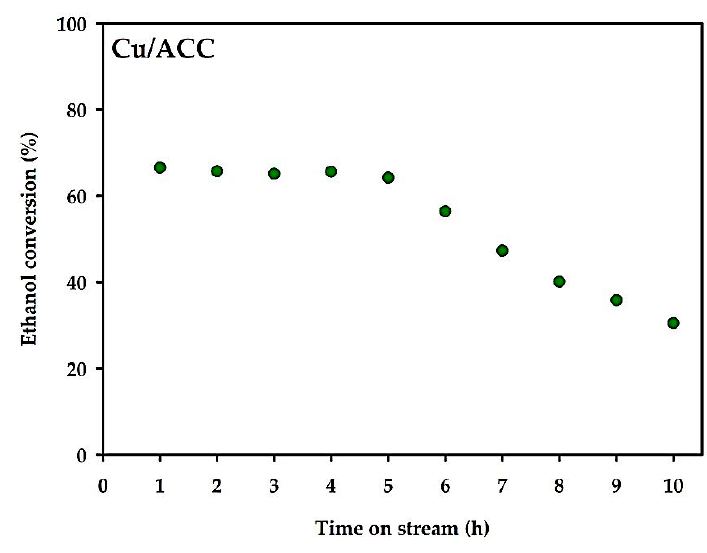
Figure 9. Stability test of Cu/ACC catalyst at 350 °C.